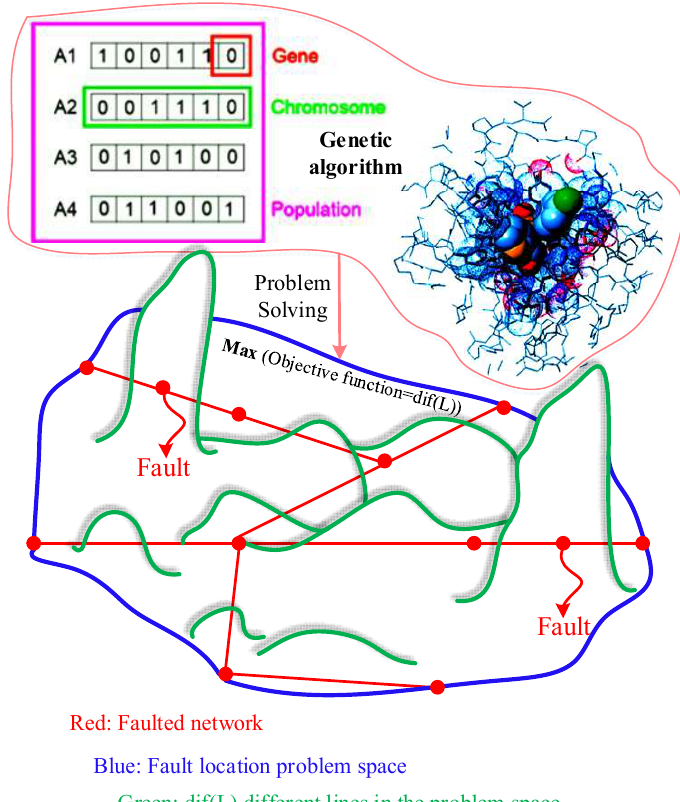
Figure 9. General space of the fault location